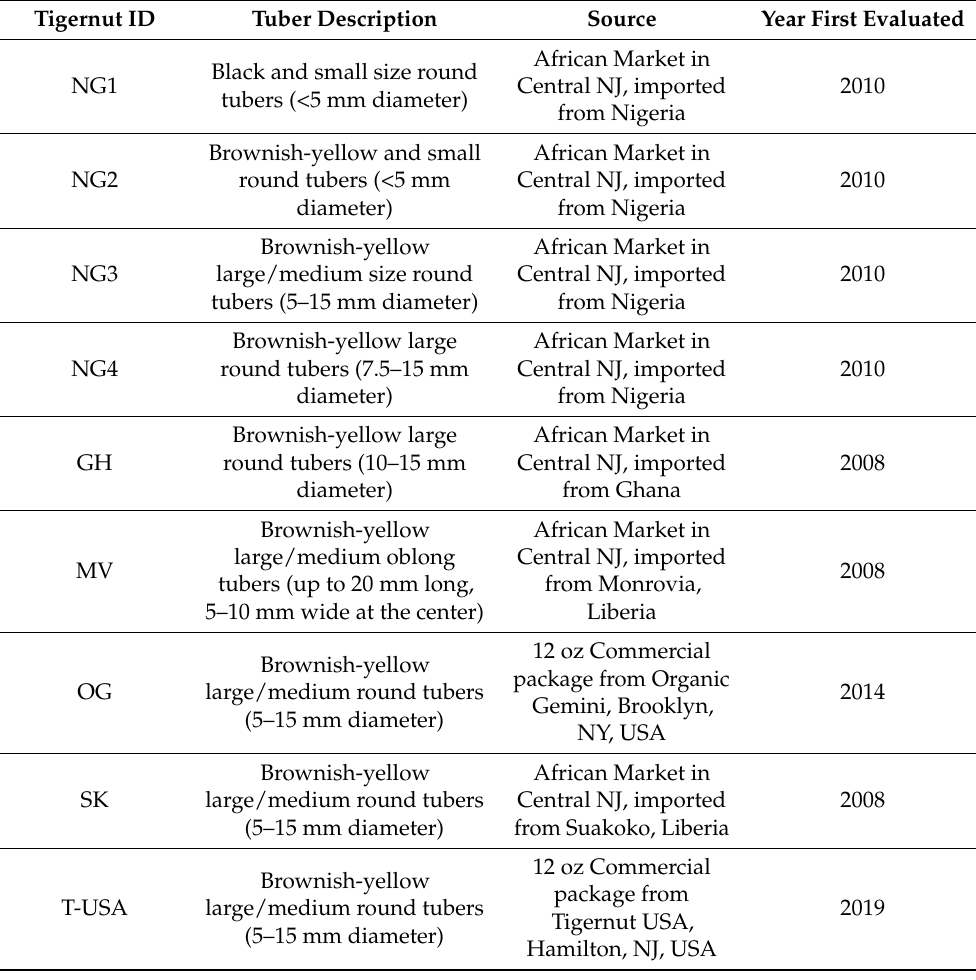
Table 2. Tigernut selections used for hoop house and field studies at Rutgers University between 2008 and